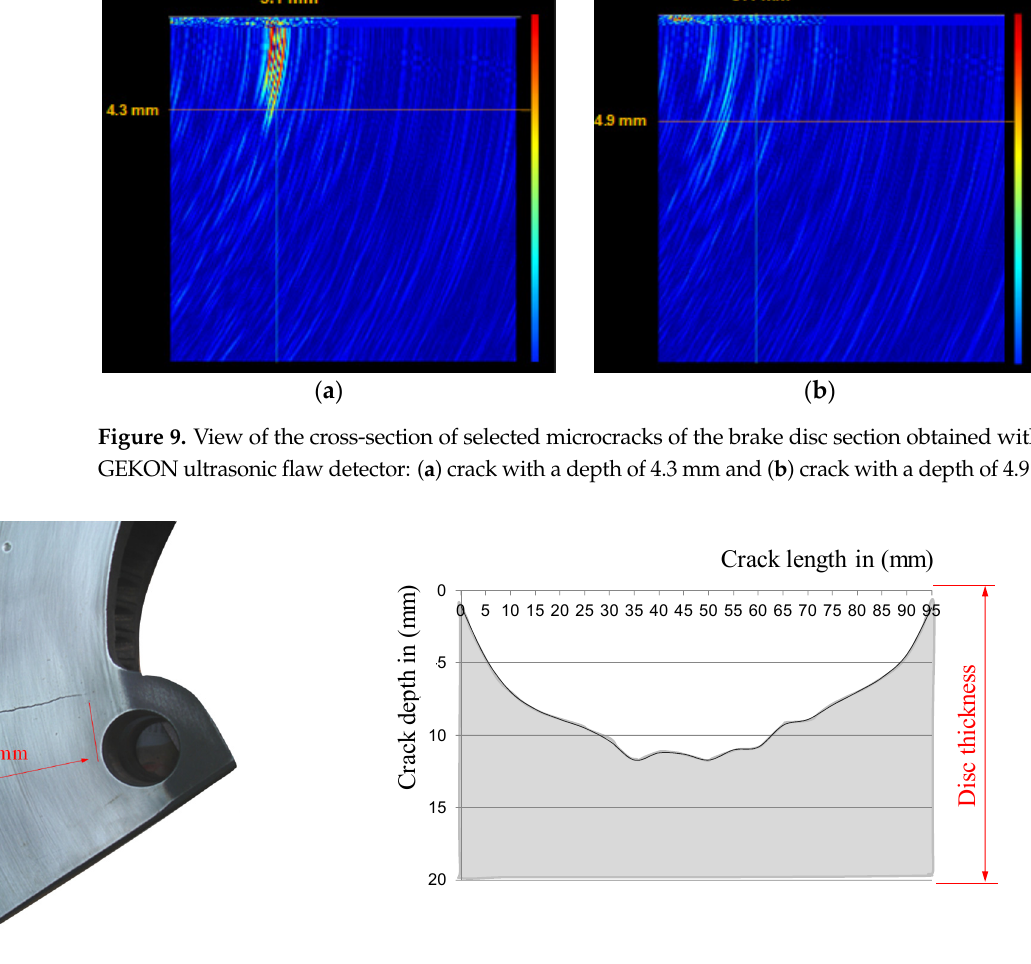
Figure 9. View of the cross-section of selected microcracks of the brake disc section obtained with the GEKON ultrasonic flaw detector: ( a ) crack with a depth of 4.3 mm and ( b ) crack with a depth of 4.9 mm.